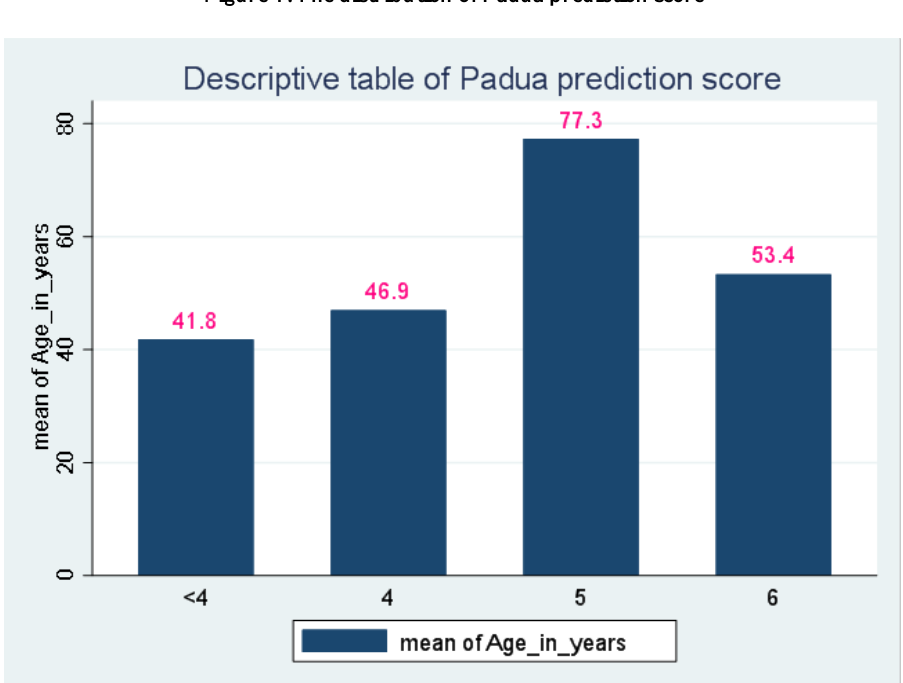
Figure 2. The distribution of Padua score by age in